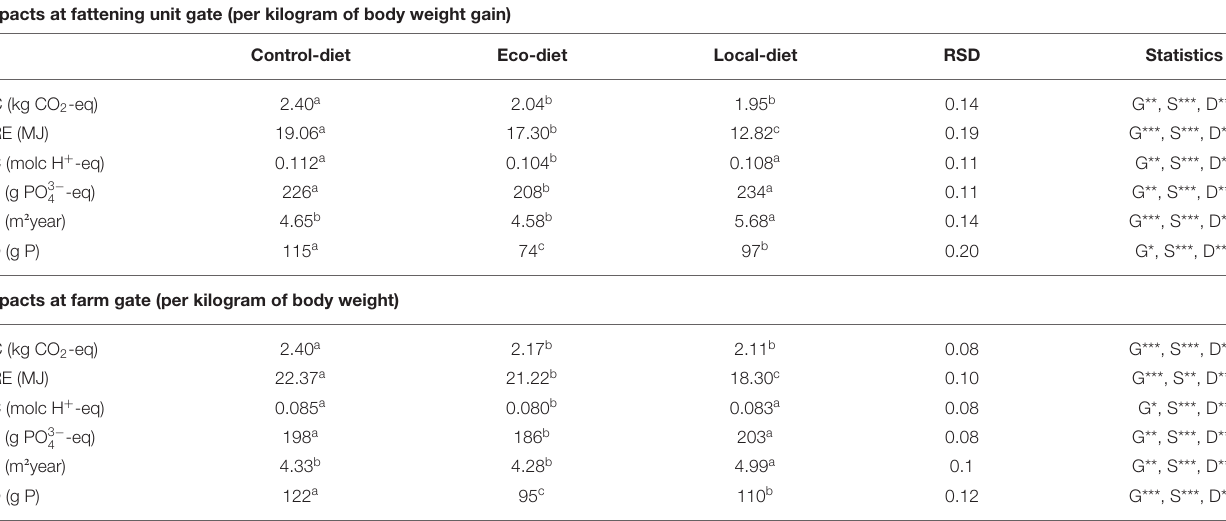
TABLE 4 | Environmental impacts at farm gate (per kilogram of body weight gain in fattening unit and per kilogram of pig live weight at farrow-to-finish farm gate). Impacts at fattening unit gate (per kilogram of body weight